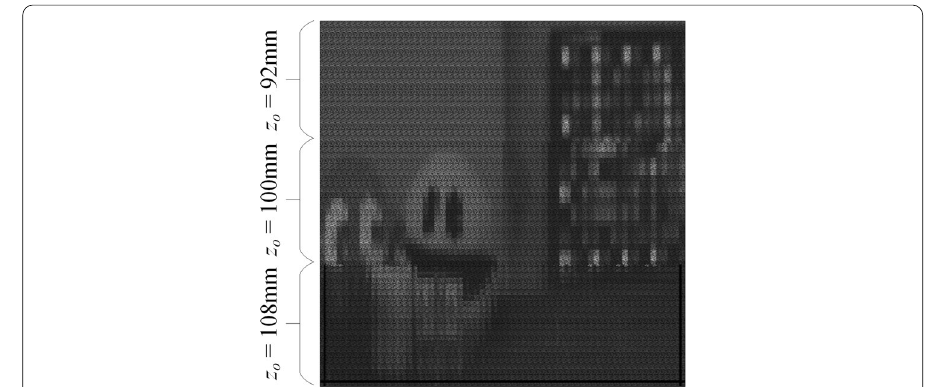
Fig. 10 The mixture spatial-spectral light field result for the second simulation